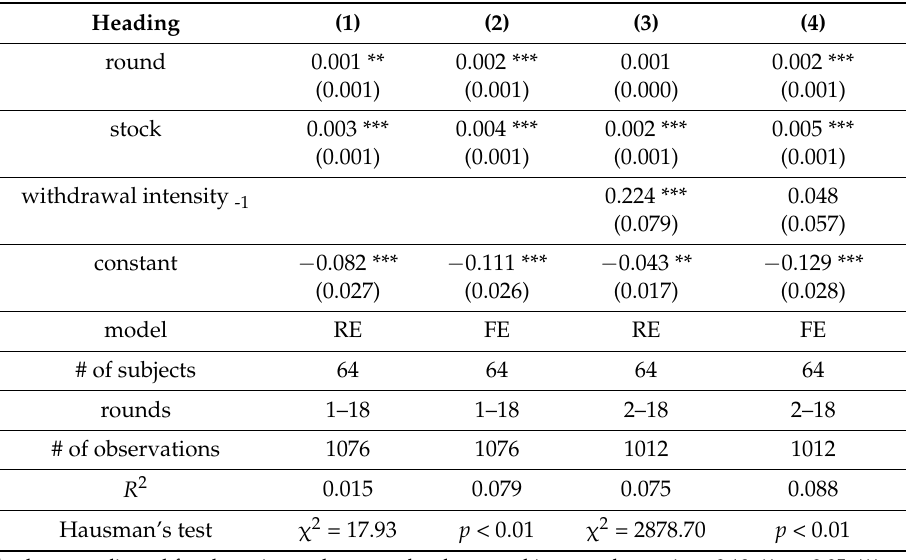
Table A3. Regressions of Withdrawal